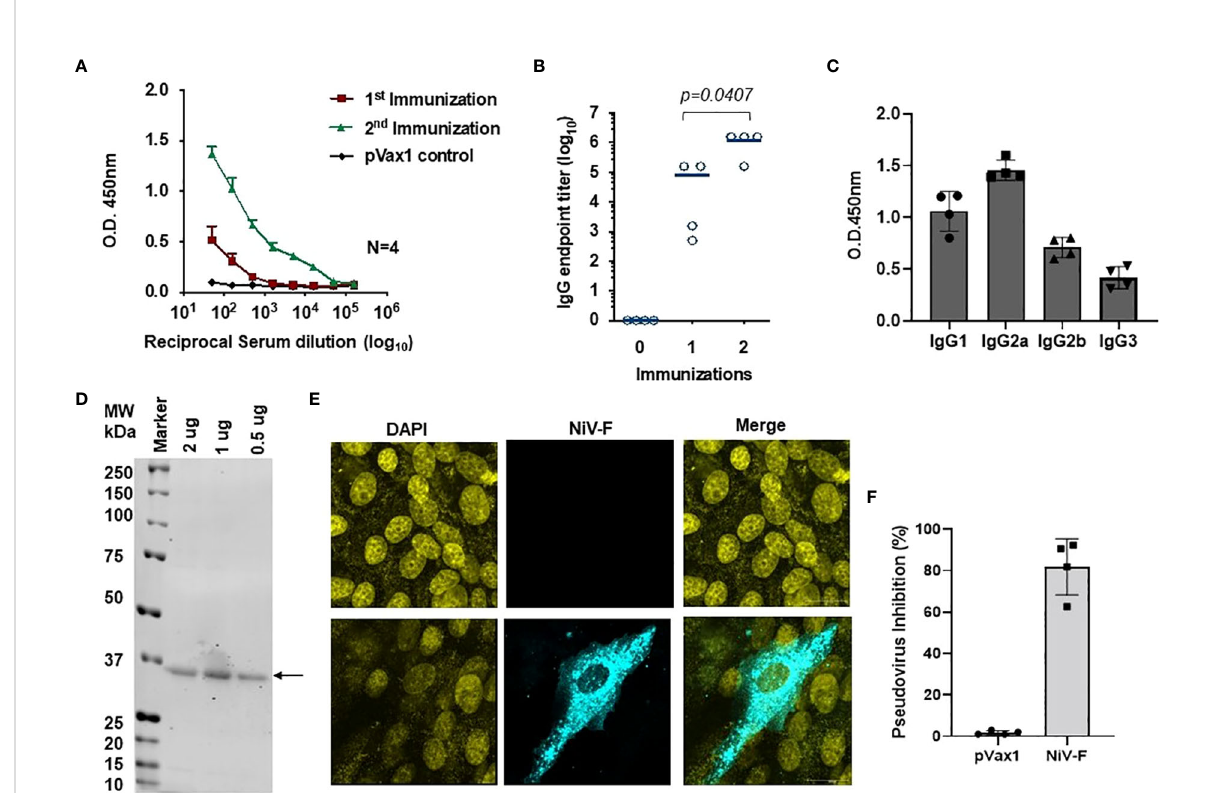
FIGURE 5 Antigen-speci fi c humoral immunity is induced by synthetic vaccine candidates expressing NiV-F. (A) Sera collected 14 days after the fi rst (prime) immunization and 7 days after the second (boost) immunization (day 28) were analyzed for NiV-F-speci fi c IgG. (B) Endpoint titers for the single and two immunization samples were measured in sera collected on day 14 (indicated as immunization 1) and 28 (indicated as immunization 2) post-immunization (n = 4 mean ± SEM). (C) IgG1, IgG2a, IgG2b, and IgG3 subclass of mouse sera were determined by ELISA in samples collected one week post second immunization (day 28). (D) Western blot of NiV-F protein detected with immune sera from mice immunized with NiV-F vaccine. The arrow indicates molecular mass. Lane M: protein size marker. (E) IFA analysis for NiV-F protein expression in Vero cells. 24h after transfection with NiV-F vaccine, immuno fl uorescence labeling was performed by incubation with the immune sera (1:100). (F) Day 28 immune sera from NiV-F vaccine-immunized mice were diluted at 1:20 and used to measure inhibition ability for NiV-F/G pseudovirus. Sera samples were measured in duplicates and the data shows one of two representative